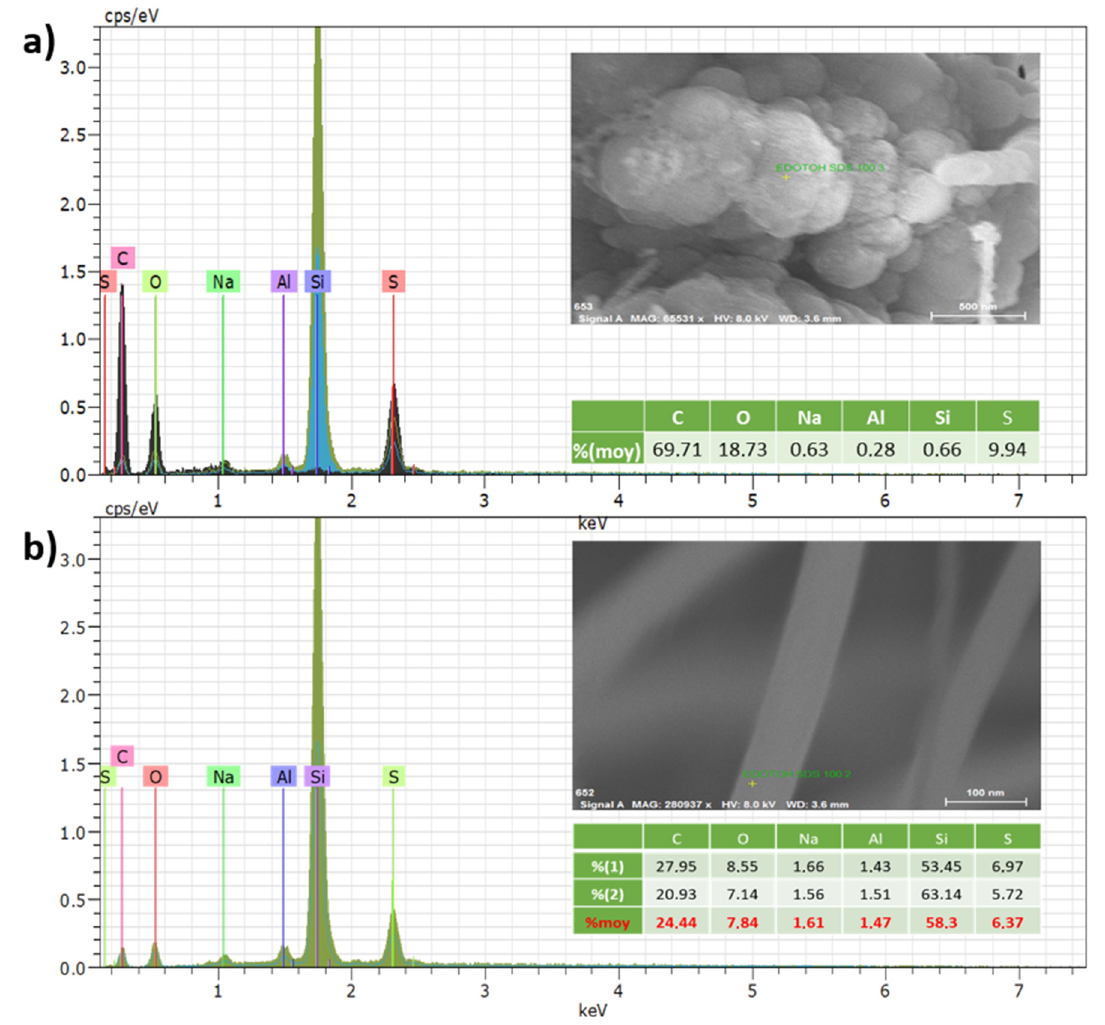
Figure 2. EDX measurements ( a ) of the apex of the Al 3 @SiNWs for large nucleation grains of EDOT-OH in SDS and ( b ) bottom of the Al 3 @SiNWs and traces of EDOT-OH deposited in SDS.